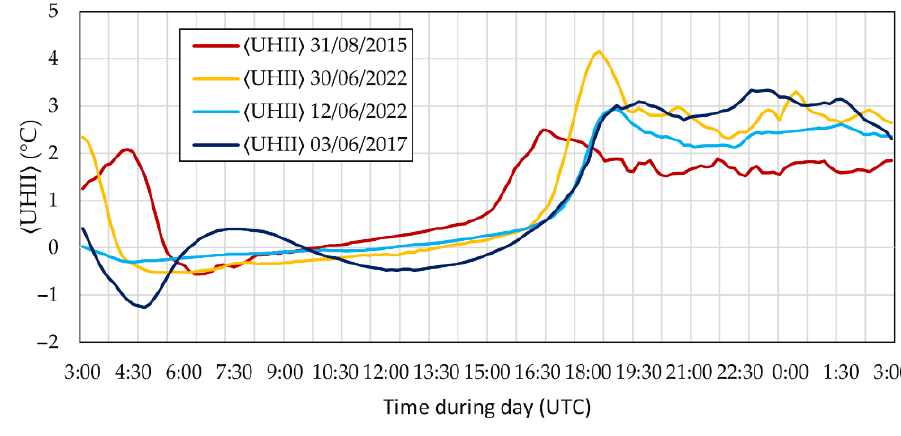
Figure 9. The development of the corrected ⟨ UHII ⟩ in time for all four scenarios in 10 min